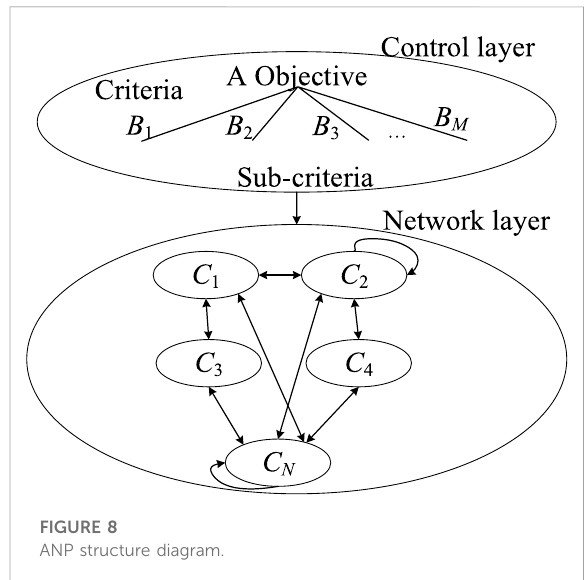
FIGURE 8 ANP structure